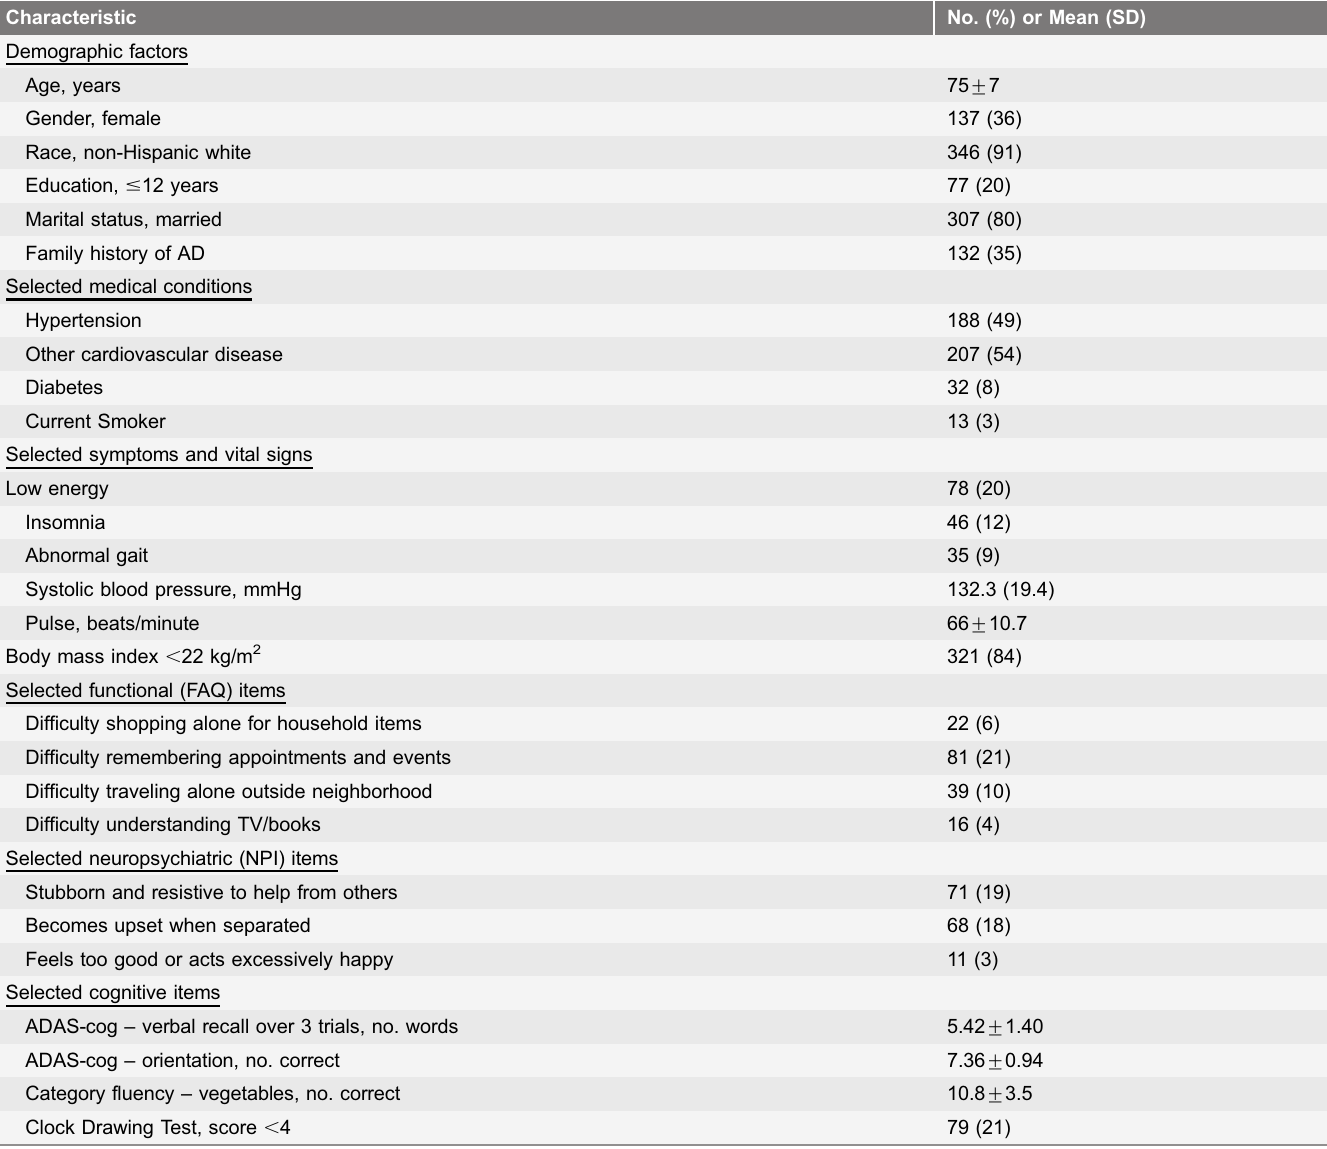
Table 1. Baseline Characteristics of 382 Participants with Amnestic Mild Cognitive Impairment